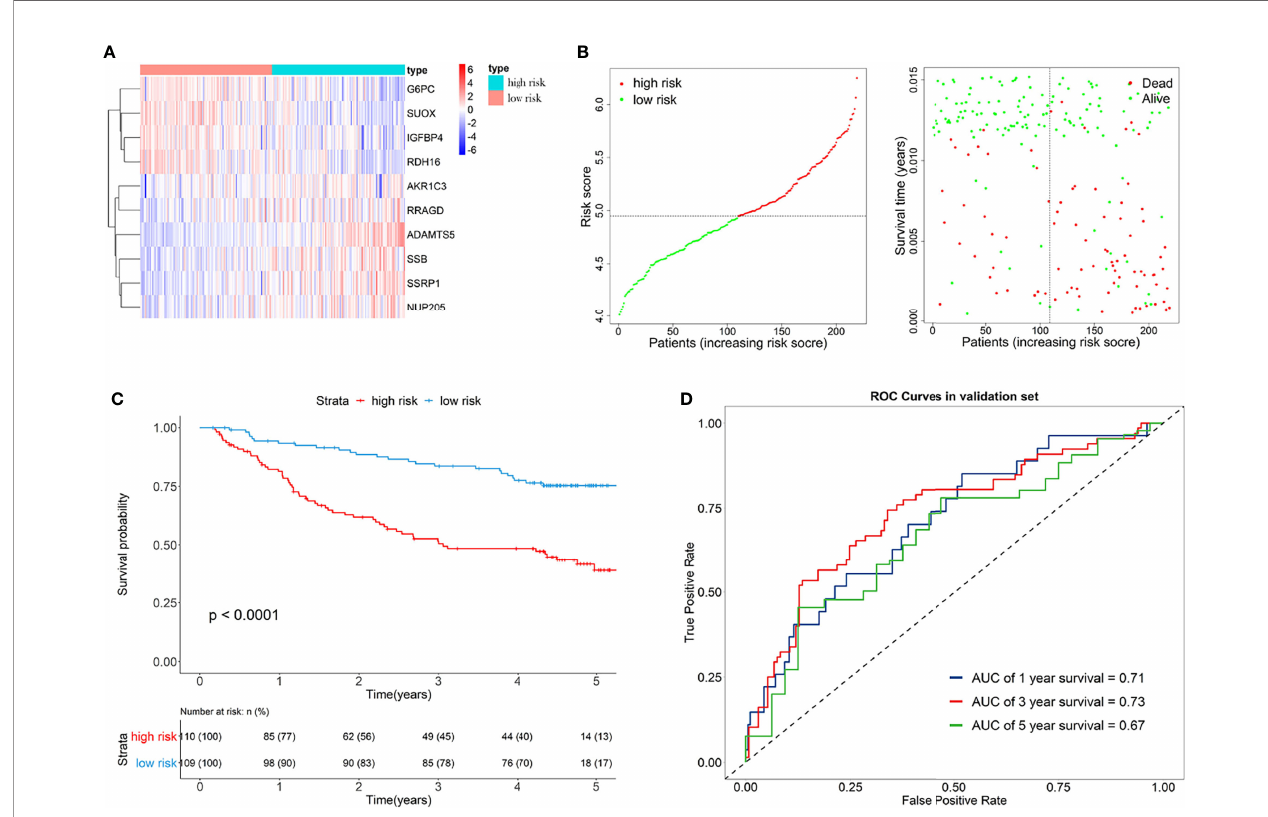
FIGURE 4 | (A) Heatmap of the signature genes expression pro fi les in validation set, and the colors represent centered and scaled log2FPKM value in the row direction (FPKM is de fi ned as fragments per kilobase of transcript per million mapped reads); (B) Survival status distribution of patients in high risk and low risk group; (C) Kaplan-Meier curves of the signature for high risk and low risk group in validation set; (D) Time-dependent ROC curves of the signature for 1-, 3-, 5-year overall survival in validation